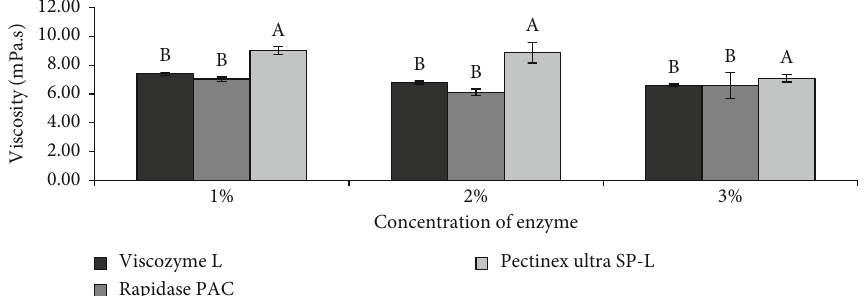
Figure 1: E ff ects of various types of cell wall degrading enzyme concentrations on viscosity (mPa.s) of Zn-amaranth puree at pH 5 and 45 ° C after 24 h. Data are expressed as the means ± standard deviation of triplicates. Means with the same letter in each column mean not signi fi cantly di ff erent ( p < 0 : 05 , ANOVA).